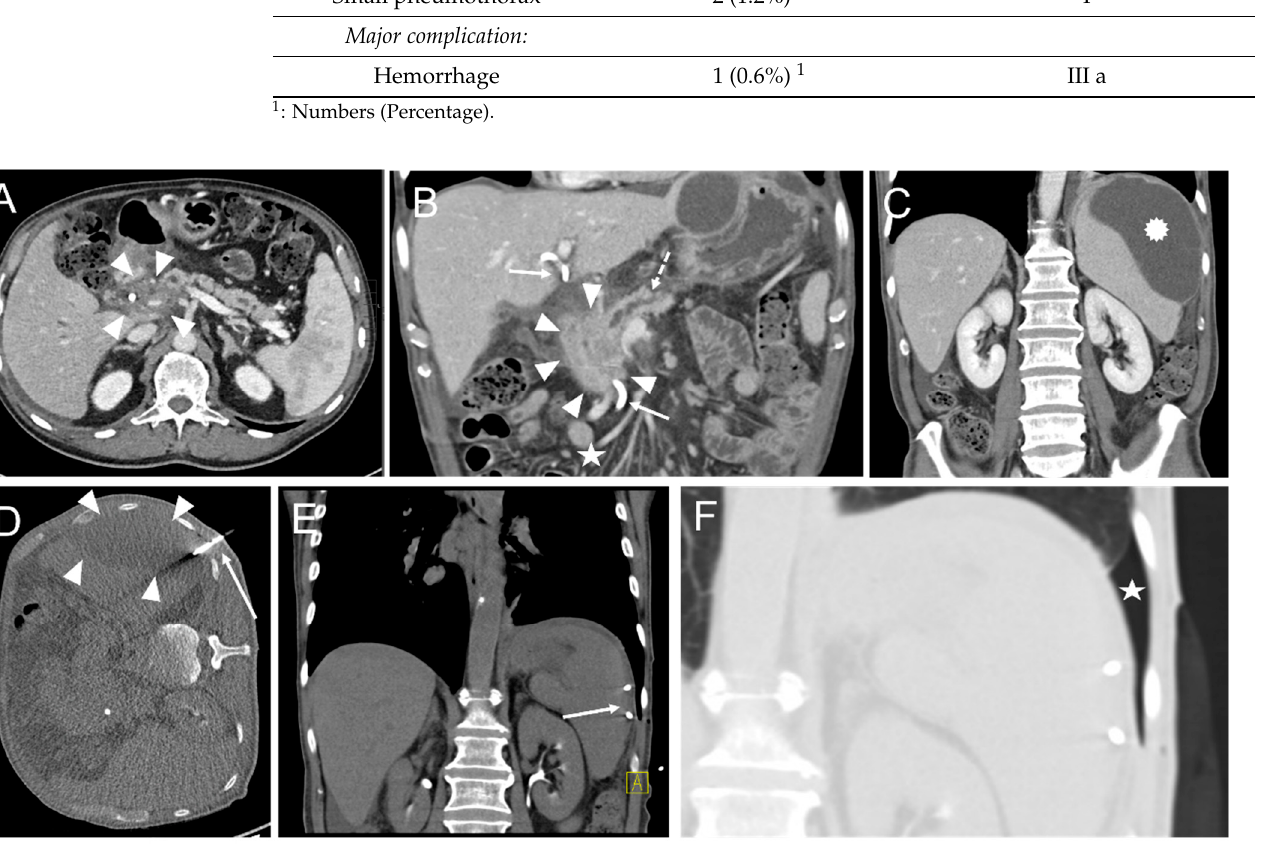
Figure 3. An intervention with a minor complication according to SIR. ( A ) 70-year-old male developing jaundice. CT scan depicts a pancreatic head tumor (arrowheads) with infiltration of the hepatic artery and spread along the portal vein as well as the mesenteric root. ( B ) Infiltration and congestion of the pancreatic duct (dashed arrow), enlarged and roundly configured lymph node metastases (asterisk), and a previously endoscopically inserted drainage (arrows). Arrowheads: pancreatic head tumor. ( C ) An exploratory laparotomy including multiple biopsy samples of the pancreas was conducted. The Patient developed postoperative pancreatitis. Twenty-seven days after surgery a pancreatogenic, perisplenic subcapsular pseudocyst (star) was diagnosed on a CT scan. ( D ) Placement of an 8F drainage (arrow) within the fluid collection (arrowheads) in the right lateral decubitus position, guided by CT fluoroscopy. ( E ) Postinterventional unenhanced control CT scan shows the correct position of the drainage (arrow) and an almost complete disappearance of the fluid collection. ( F ) However, a small self-limiting pneumothorax (star) was observed in the lung